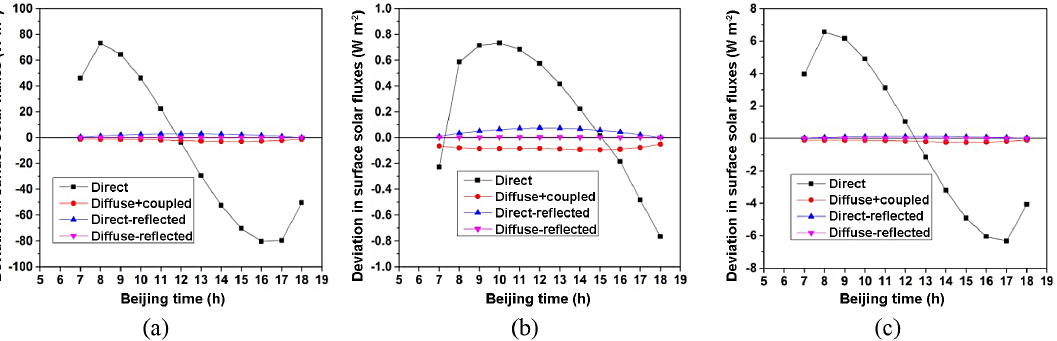
Figure 5. Contributions of individual components to surface solar flux deviations between the 3-D radiation parameterization and the plane- parallel scheme in clear-sky condition without aerosols in typical grids on 1 April. Panel (a) , (b) , and (c) are for the same grids as Fig. 4a, b, and